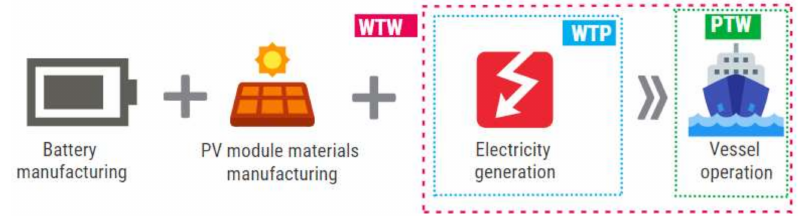
Figure 4. The life-cycle of the PV cell battery-powered ship